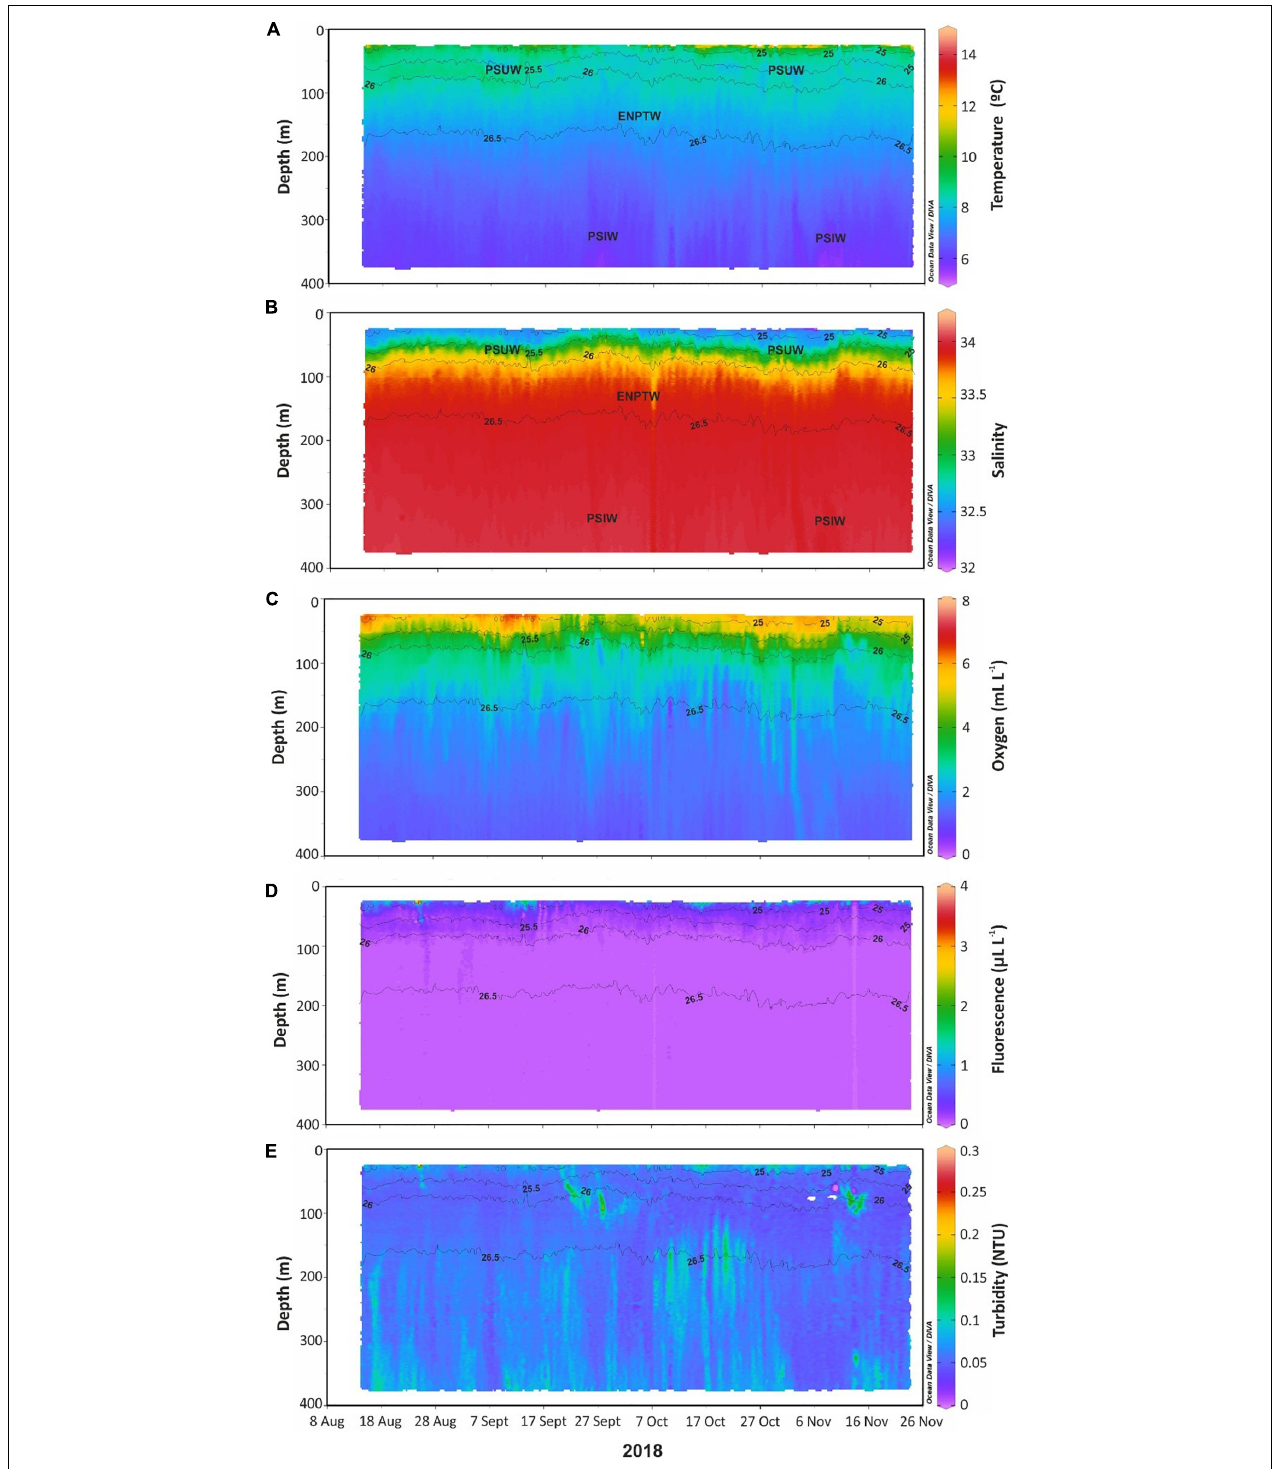
FIGURE 5 | Time series of (A) potential temperature ( ◦ C), (B) salinity, (C) dissolved oxygen (mL · L – 1 ), (D) fluorescence ( µ L · L – 1 ), and (E) turbidity in NTU (Nephelometric Turbidity Units) measured by the Vertical Profiling System (VPS) during the study period, spanning from the 14th of August to the 23rd of November 2018, showing the different water masses present in the study area: Pacific Subarctic Upper Water (PSUW), Eastern North Pacific Transition Water (ENPTW) and Pacific Subarctic Intermediate Water (PSIW) (data plotted using Ocean Data View 4.7.10; http://odv.awi.de; Schlitzer, 2010). For interpretation of the color in this figure legend, the reader is referred to the web version of this